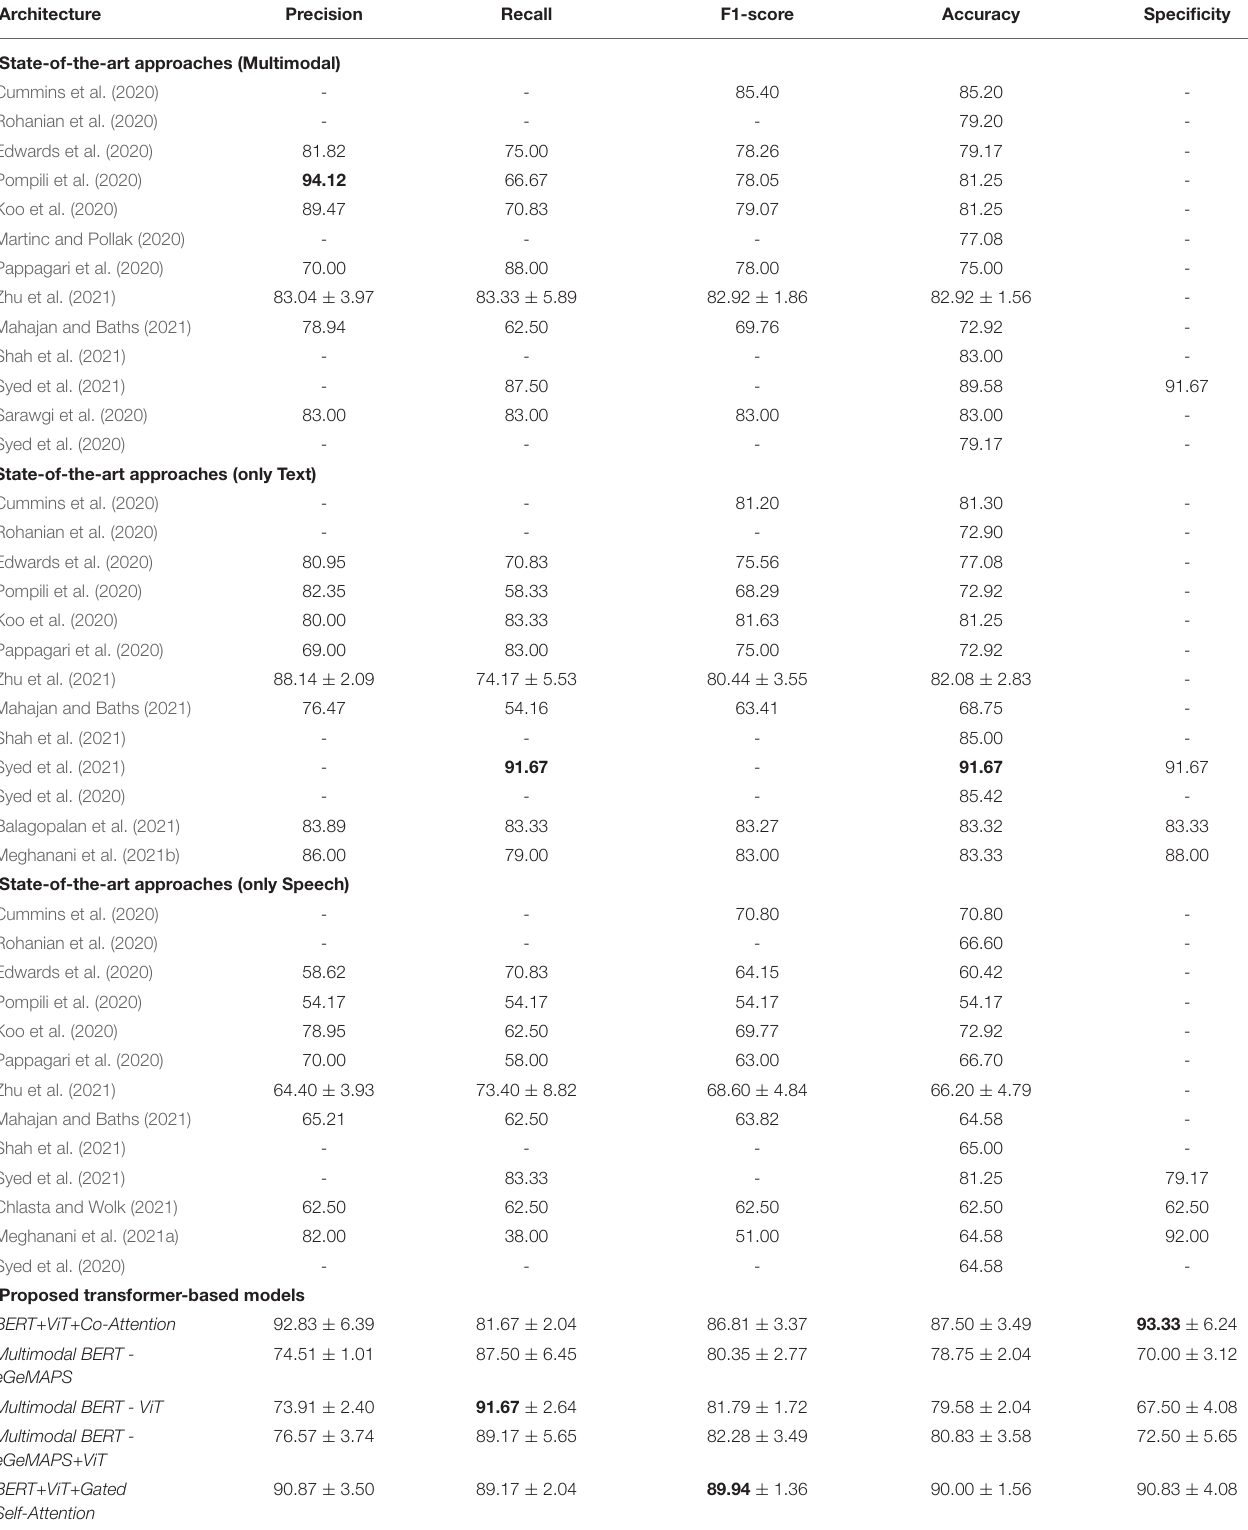
TABLE 4 | AD Classification Task: Performance comparison among proposed models and state-of-the-art approaches on the ADReSS Challenge test set.